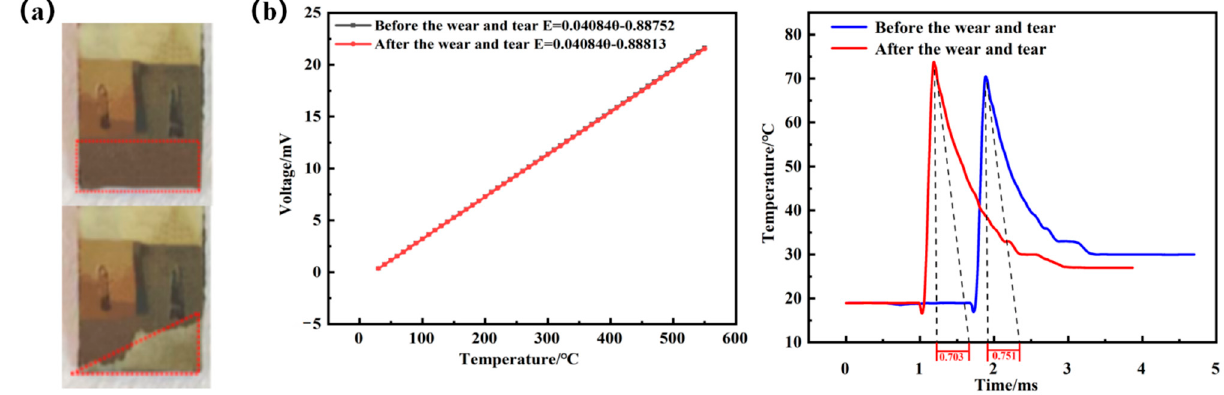
Figure 12. ( a ) Comparison of static calibration curves before and after wear. ( b ) Comparison of dynamic calibration curves before and after wear.